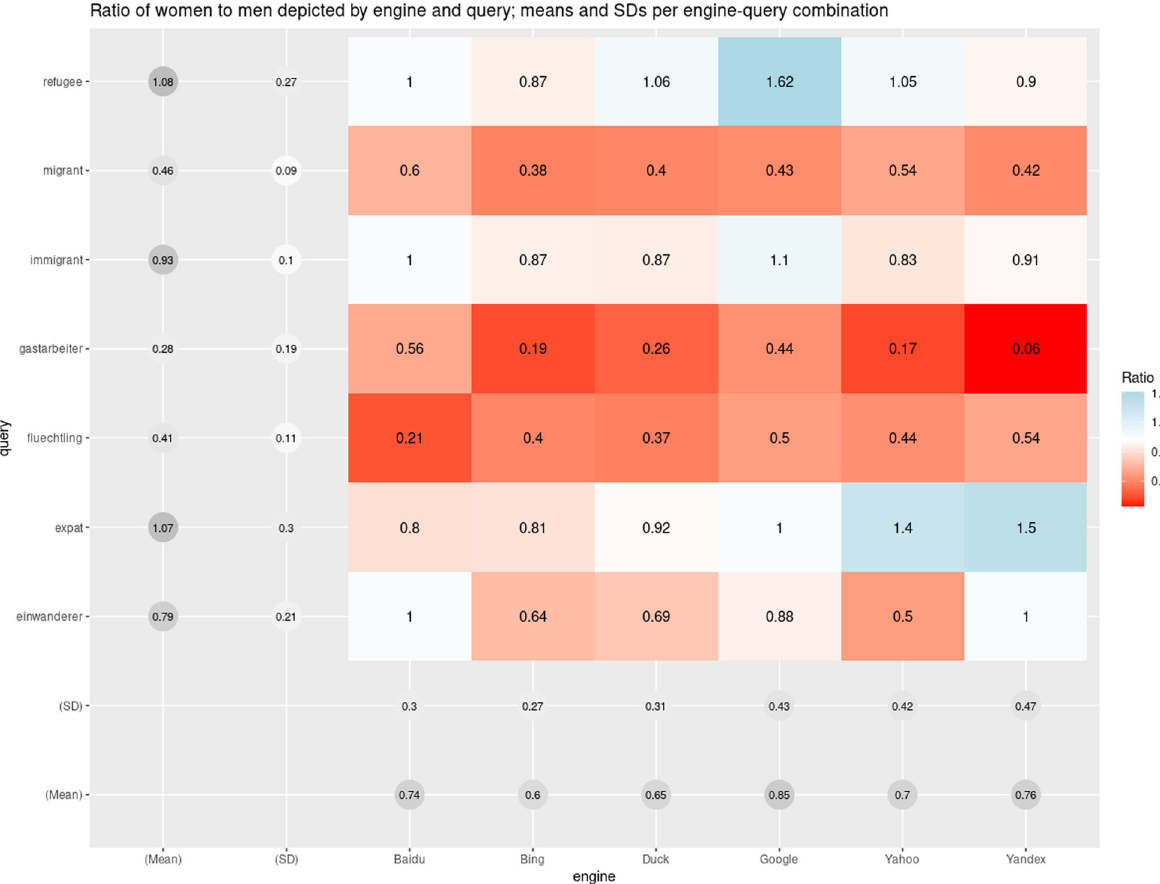
Fig. 4 Women to men ratio in images by engine and query. Ratio of women to men in images depicting people by search engine and